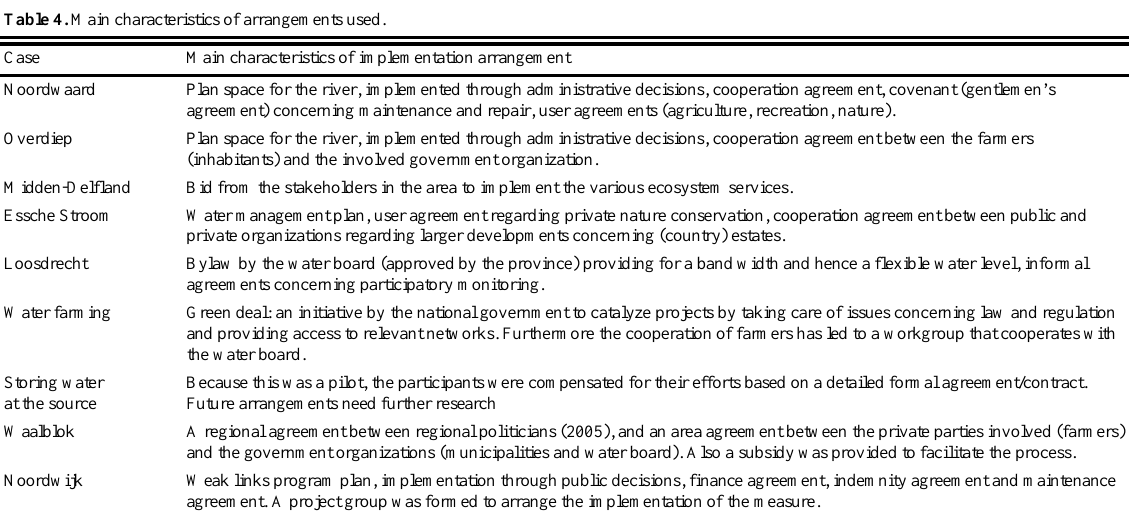
Table 4. Main characteristics of arrangements